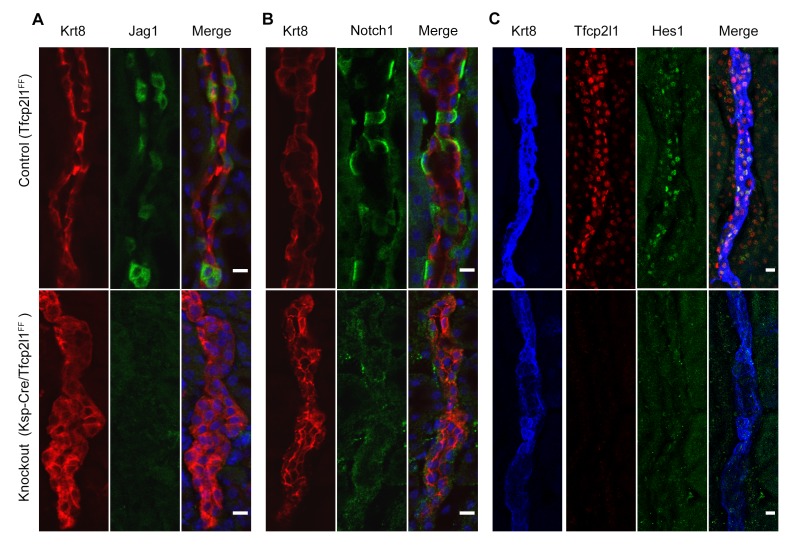
Tfcp2l1 is required for Notch signaling in collecting ducts.Tfcp2l1 knockout (Cdh16-Cre;Tfcp2l1f/f) results in A depletion of Jag1 (green) from Krt8-β-ICs (red) B. depletion of cell surface (inactive) Notch1 (green) from Krt8- α-ICs (red) C depletion of nuclear Hes (green) from Krt8+ PCs. (n = 4 independent mice for each immunodetection; Bars = 10 µm).